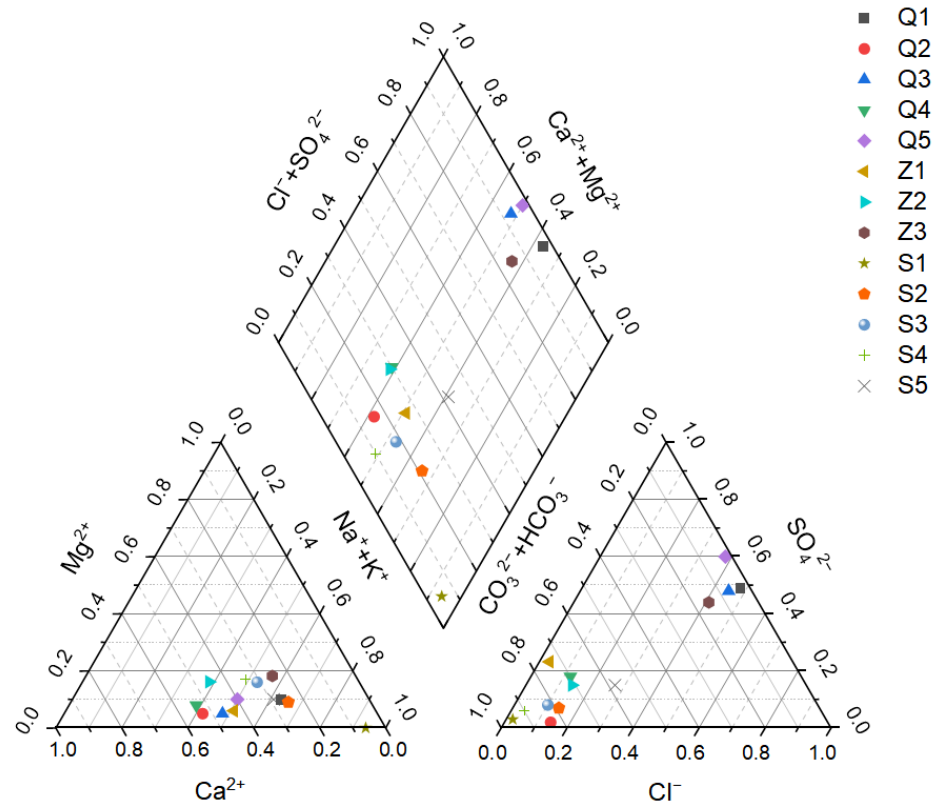
Figure 3. Piper diagram of chemical compositions for groundwater.